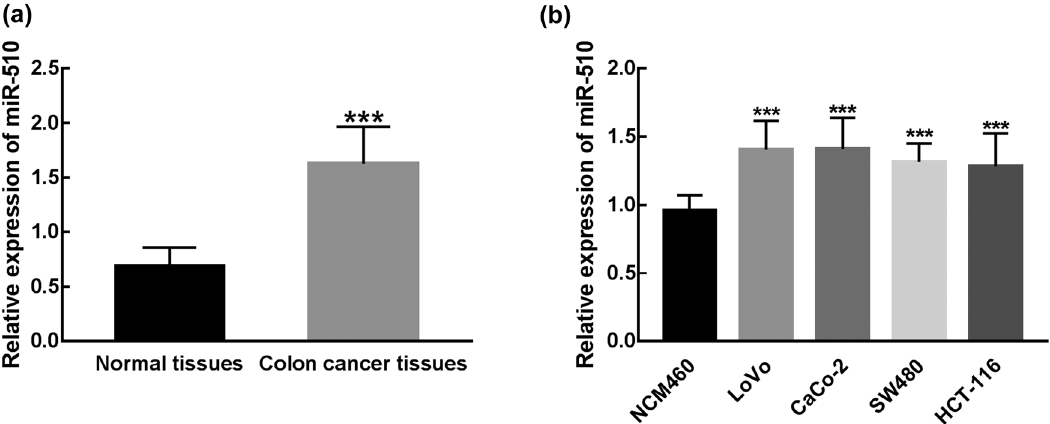
Figure 1: The expression of miR - 510 in collected tissues and cultured cell lines. ( a ) miR - 510 was signi fi cantly upregulated in colon cancer tissues compared with that in adjacent normal tissues ( *** P < 0.001 ) . ( b ) miR - 510 was signi fi cantly upregulated in colon cancer cell lines ( LoVo, CaCo - 2, SW480, and HCT - 116 ) compared with normal colonic mucosa cells ( NCM460 ) ( *** P < 0.001 )